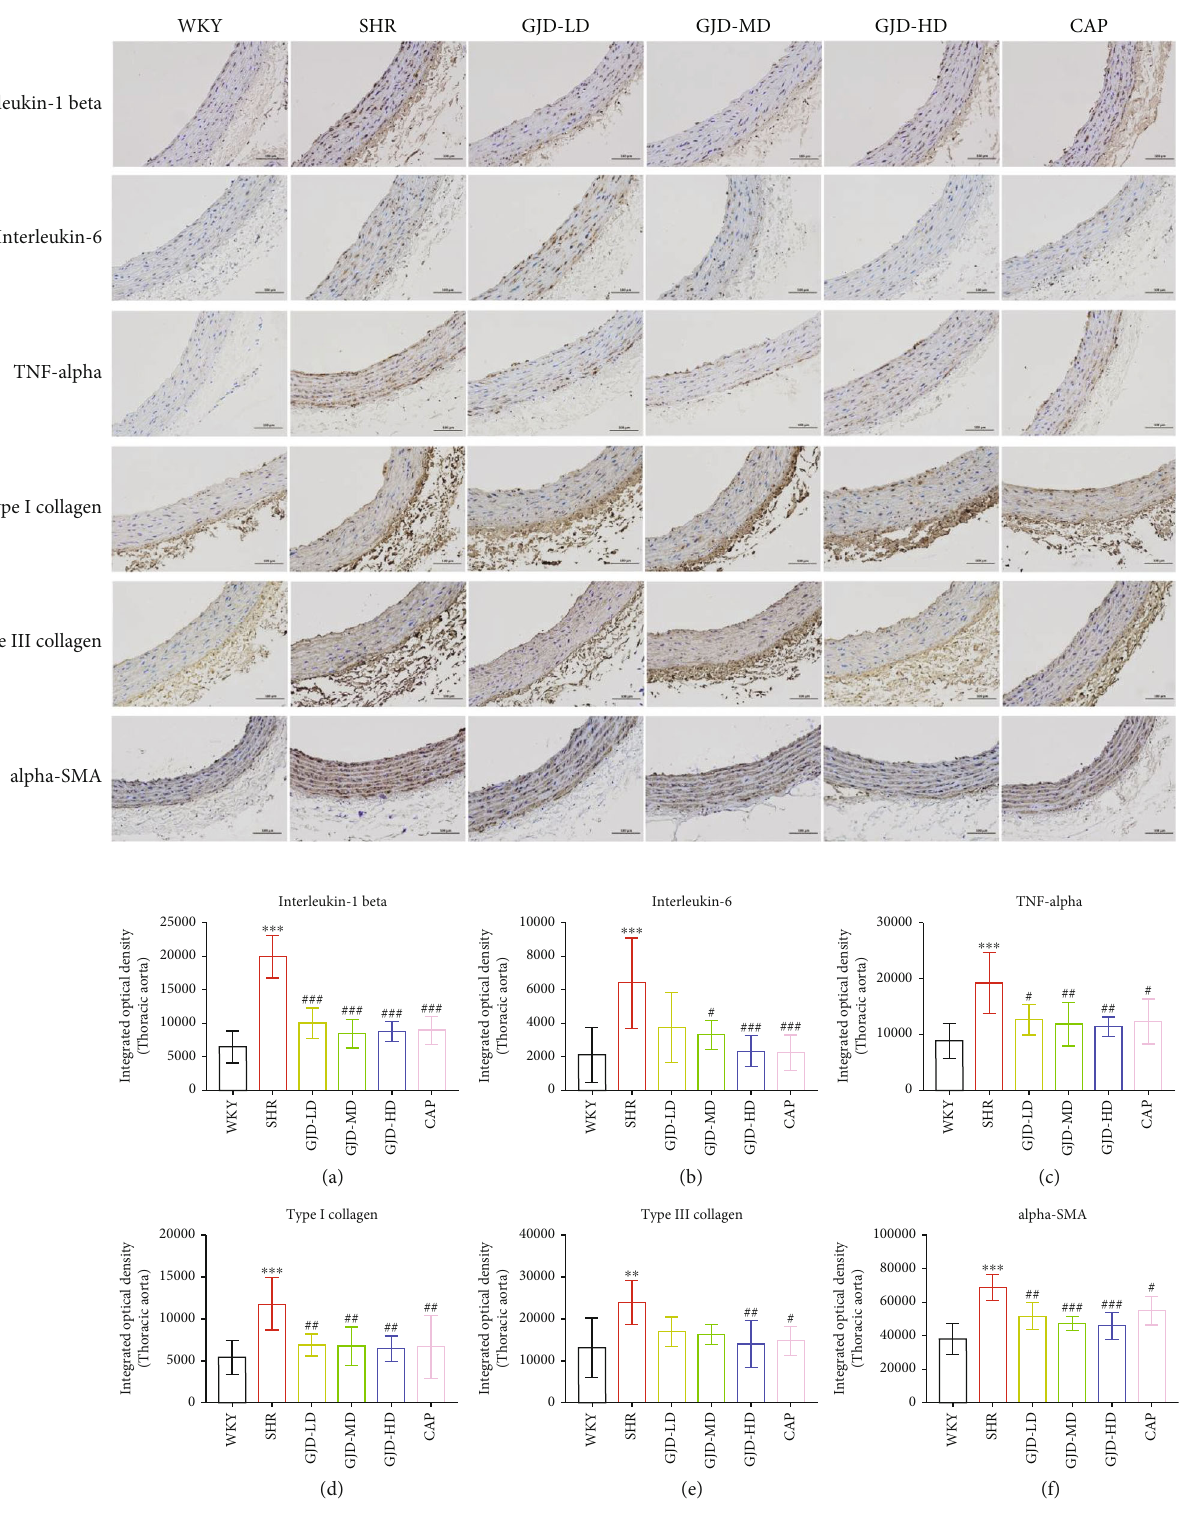
Figure 8: In the thoracic aorta, immunohistochemistry sections and quanti fi cation of protein expressions of interleukin -1 beta, interleukin-6, TNF-alpha, type I collagen, type III collagen, and alpha-SMA. (A) Interleukin-1 beta, (B) interleukin-6, (C) TNF-alpha, (D) type I collagen, (E) type III collagen, and (F) alpha-SMA. The images were taken at a magni fi cation of × 200. Scale bar=100 μ m. WKY indicates the WKY control group, SHR indicates the SHR model group, GJD-LD indicates the SHR treated with GJD at a low dose, GJD-MD indicates the SHR treated with GJD at a medium dose, GJD-HD indicates the SHR treated with GJD at a high dose, and CAP indicates SHR treated with captopril. Data are means ± SD . n = 7 . ∗ P < 0 : 05 , ∗∗ P < 0 : 01 , ∗∗∗ P < 0 : 001 vs. WKY group, # P < 0 : 05 , ## P < 0 : 01 , ### P < 0 : 001 vs. SHR